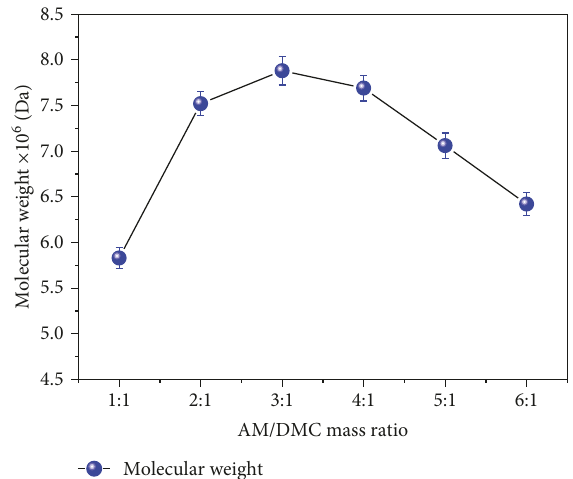
ff ect of photoinitiator concentration on the molecular weight of PAD.